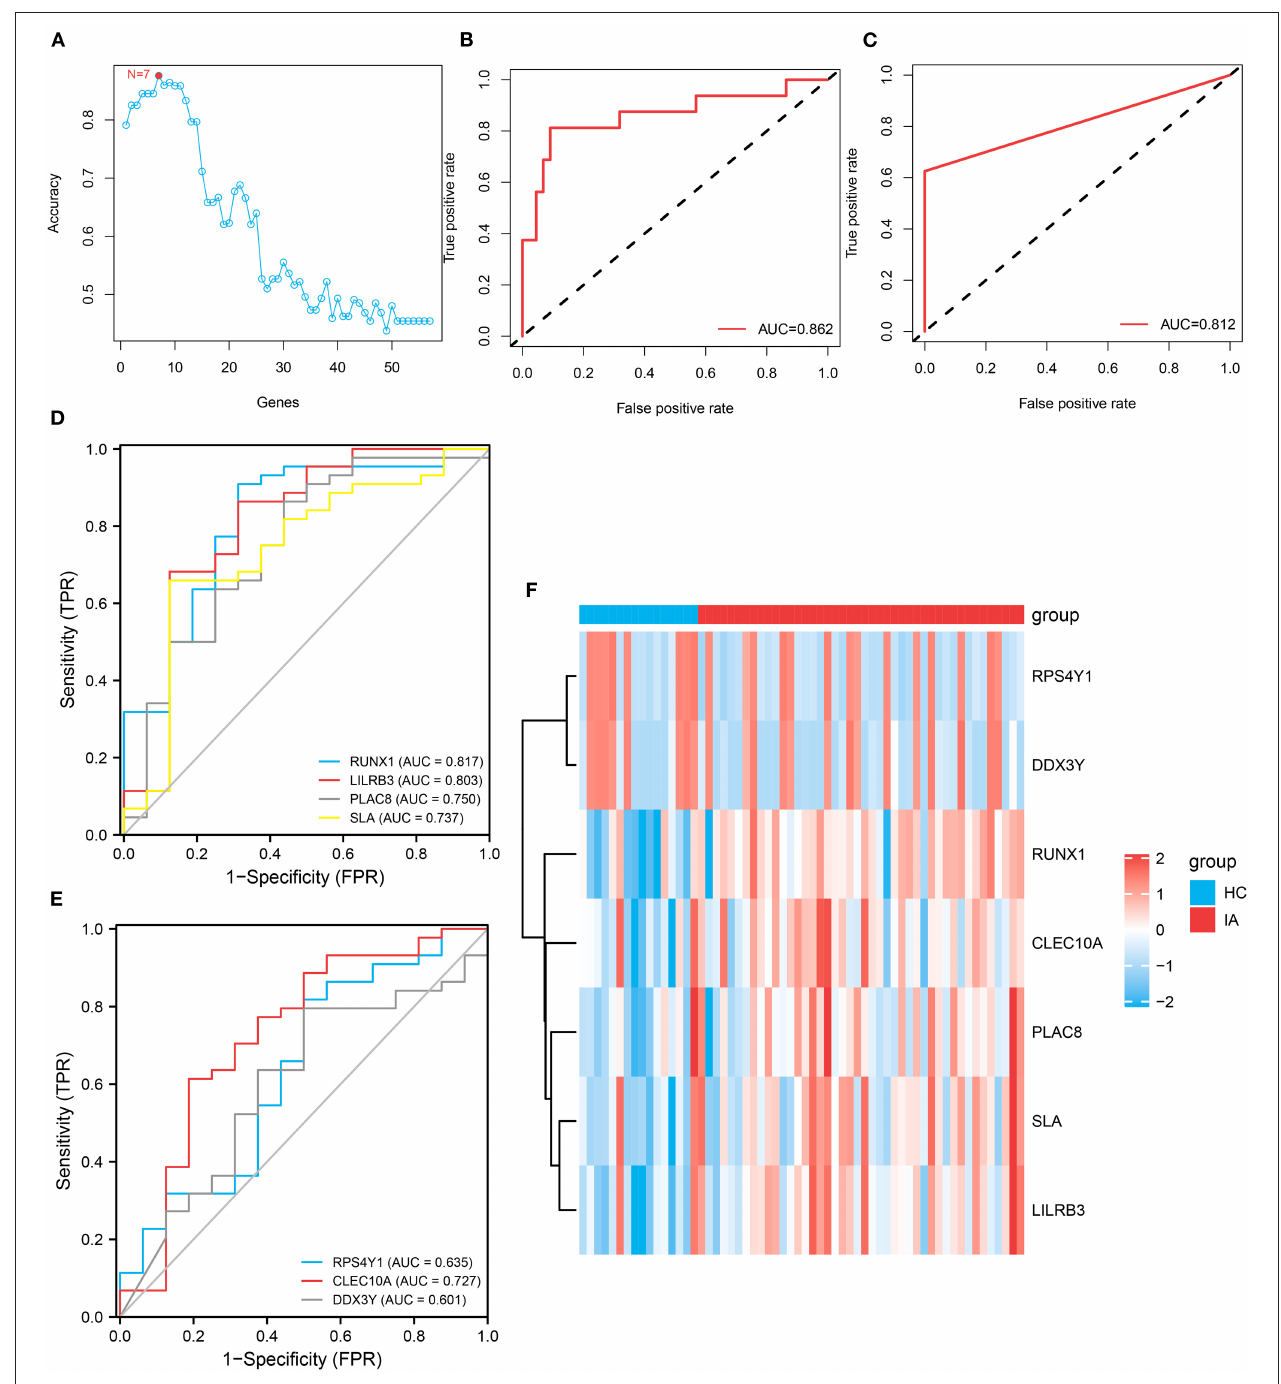
FIGURE 5 | Construction and variable selection of the intracranial aneurysm prediction model using the Support Vector Machines–Recursive Feature Elimination (SVM–RFE) algorithm. (A) Broken line graph of the number of genes identified using the SVM–RFE model and the accuracy of the model. Hence, the highest accuracy can be achieved using the SVM model constructed from seven genes. (B) Receiver operating characteristic (ROC) curve based on the SVM model constructed from these seven genes, with an area under the curve (AUC) value of 0.862. (C) Validation of this seven-gene SVM model by ROC analysis with an external cohort. (D,E) ROC curves showing the AUCs of RUNX1 , LILRB3, PLAC8, SLA, RPS4Y1, CLEC10A, and DDX3Y . (F) Heatmap depicts the expression distribution of these seven genes in the bulk RNA of IA.